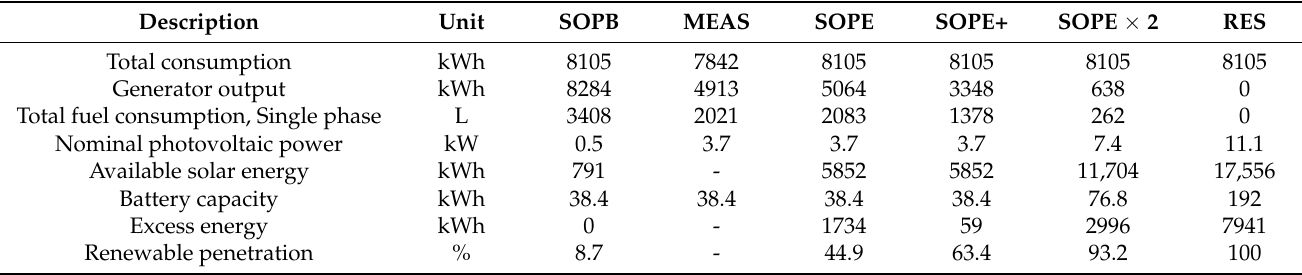
Table 3. Results of different